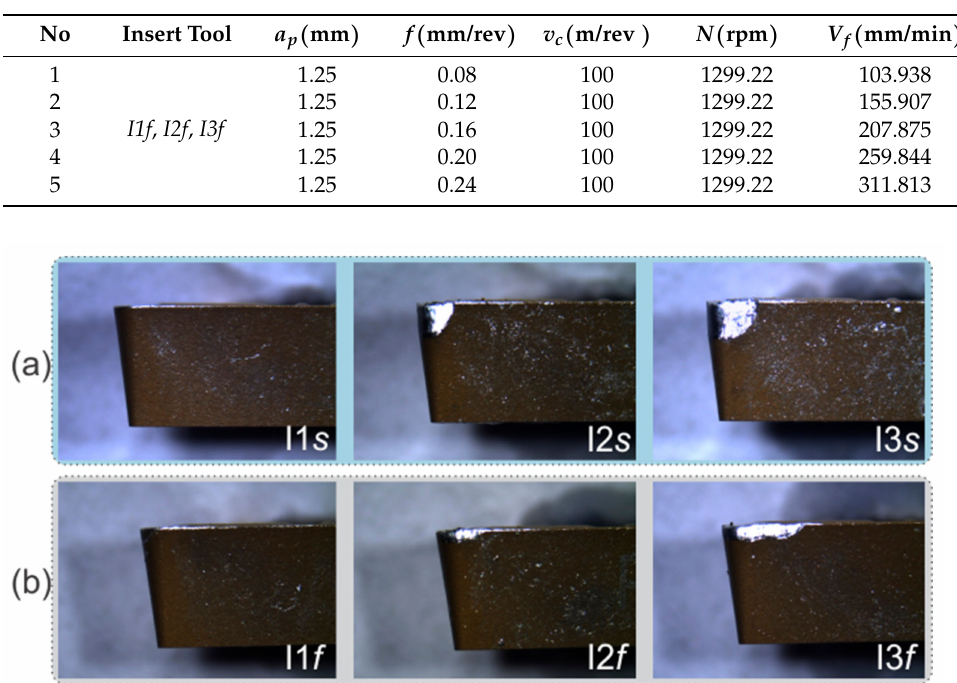
Table 3. Cutting parameters for feed rate variations.